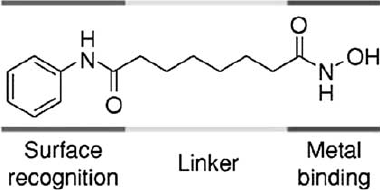
Fig. 4. Structural features of hydroxamic acid-based HDACIs. Reprinted from Advances in Cancer Research, 91, PA Marks, VM Ri- chon, T Miller, WK Kelly , Histone Deacetylase Inhibitors, 137–168, Copyright 2004, with permission from